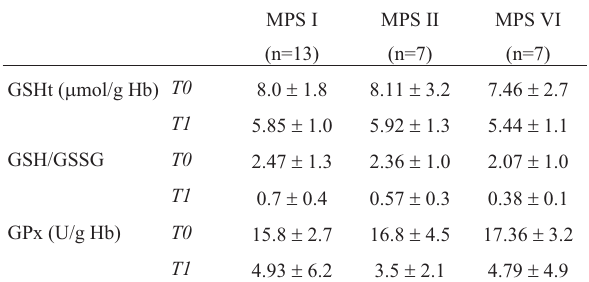
Table 2 - GPx, GSHt and GSH/GSSG ratio of MPSs patients